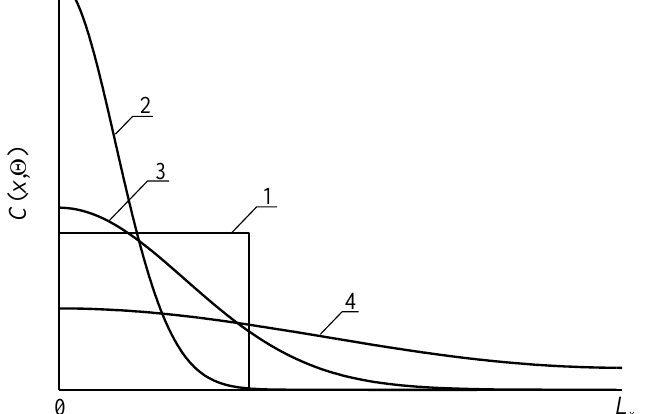
Fig. 4. Spatial distributions of dopant in heterostructure after dopant